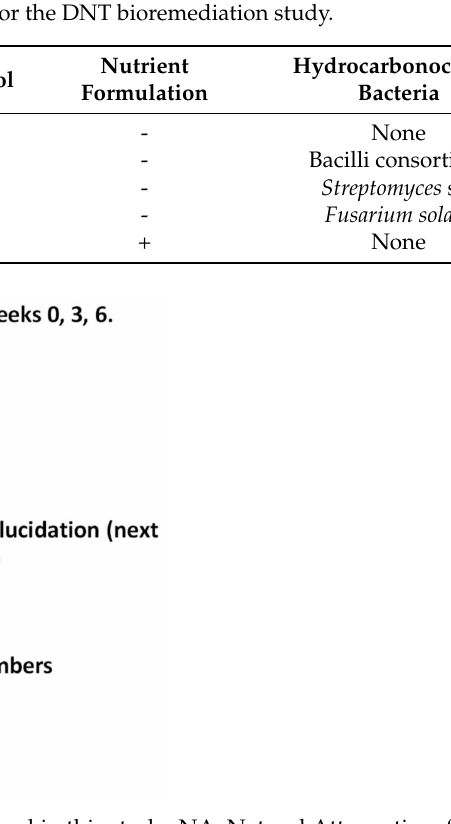
Figure 1. Scheme of the methodology followed in this study. NA: Natural Attenuation; five treat- ments were set up and analysed at the start of the experiment, weeks 3 and